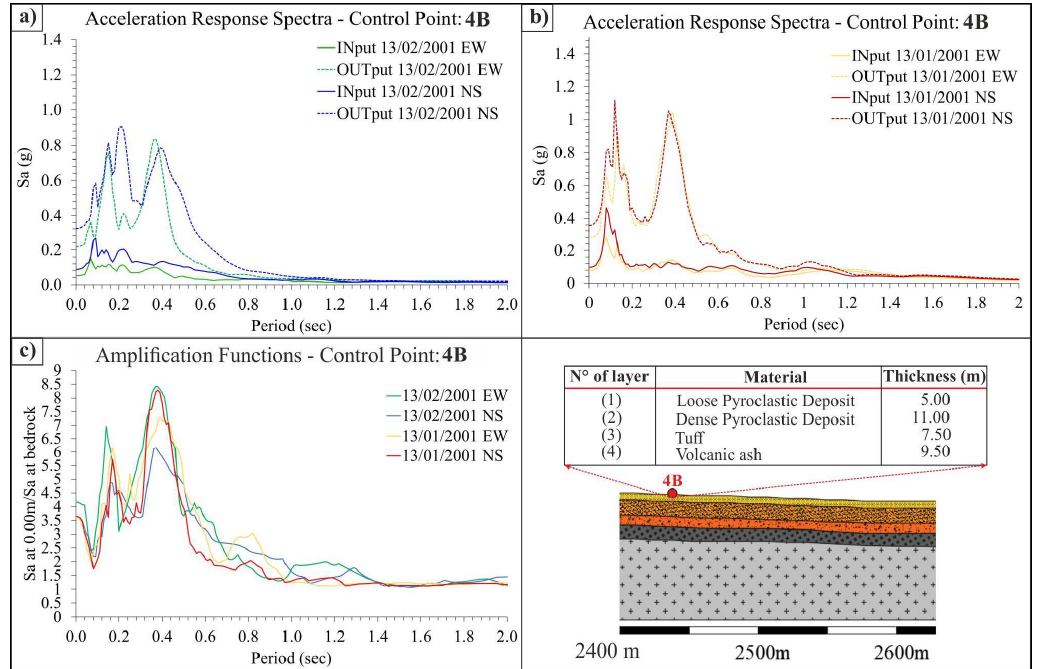
Figure 21. Section BB′: numerical control point 4B spectral responses obtained by 2D numerical analyses using LSR2D software. ( a ) Comparison among the SA of the two components of the 13 February 2001 earthquake. ( b ) Comparison among SA of the two components of the 13 January 2001 earthquake. ( c ) Amplification functions related to the four input motions.